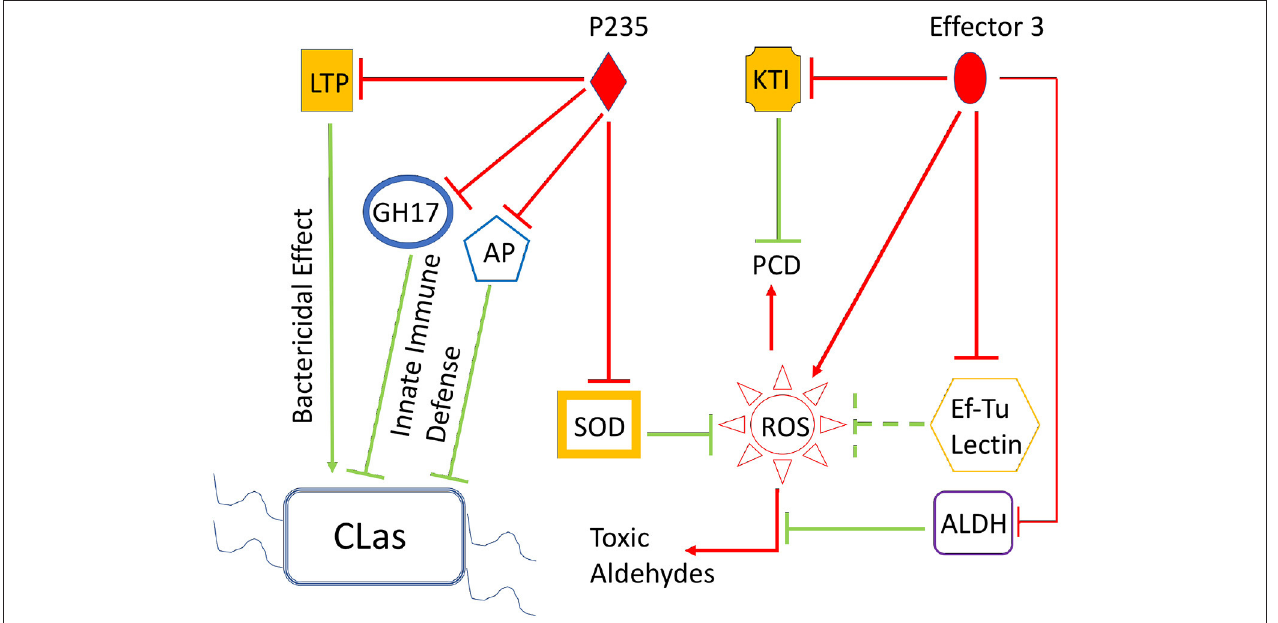
FIGURE 5 | Combined effect of the C Las effectors, LasP 235 and Effector 3, on the citrus innate immune due to the target proteins. The LasP 235 targets shown here are SOD, LTP, KP, and GH17 whereas the Effector 3 targets are as follows: ALDH, Lectin, KTI, and Ef–Tu. All these citrus targets participate in innate immune defense (shown as green arrows) during bacterial infection. For example, SOD controls the level of ROS such that the beneficial effects of ROS-induced immune defense can be harnessed without the level of ROS level exceeding a critical threshold over which there may cause host damage. EF–Tu and ALDH also limit the level of ROS. The GH17 and KP offer immune defense against bacterial infection. LTP can directly exert bacterial effect whereas KTI prevents premature PCD, which may help bacterial growth and infection. The effects of pathogenic C Las proteins, LasP 235 and Effector 3, are shown as red line arrows (promoting a process and red line blockers (as inhibiting a process). The combined effects of LasP 235 and Effector 3: elevation of ROS level, premature PCD, and inhibition of C Las